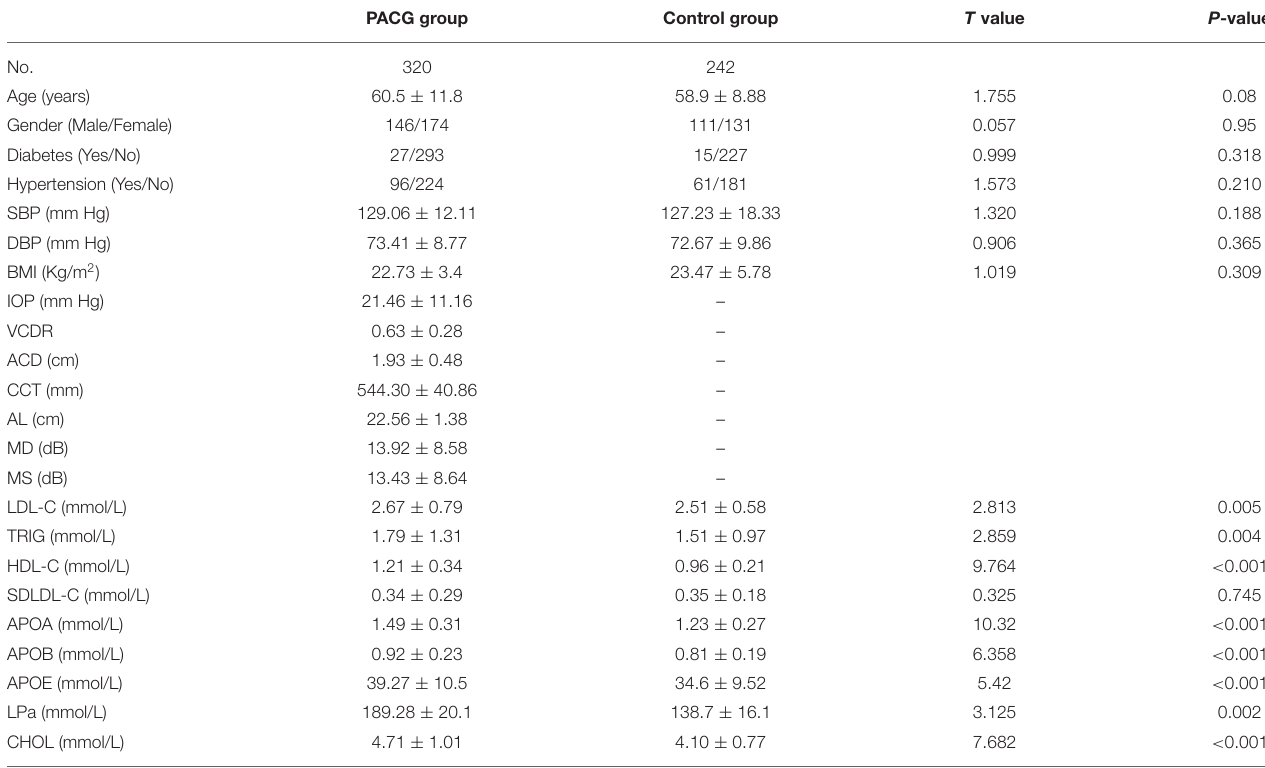
TABLE 1 | Demographics parameters and serum lipids levels of the PACG and control groups.